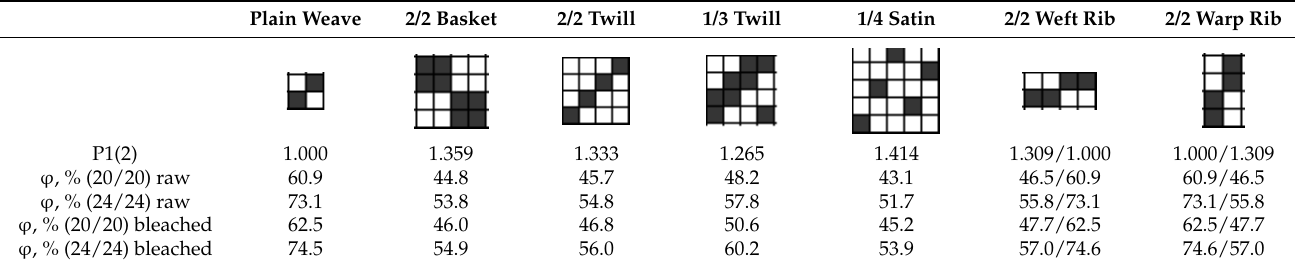
Table 2. Weave and firmness factors. Plain